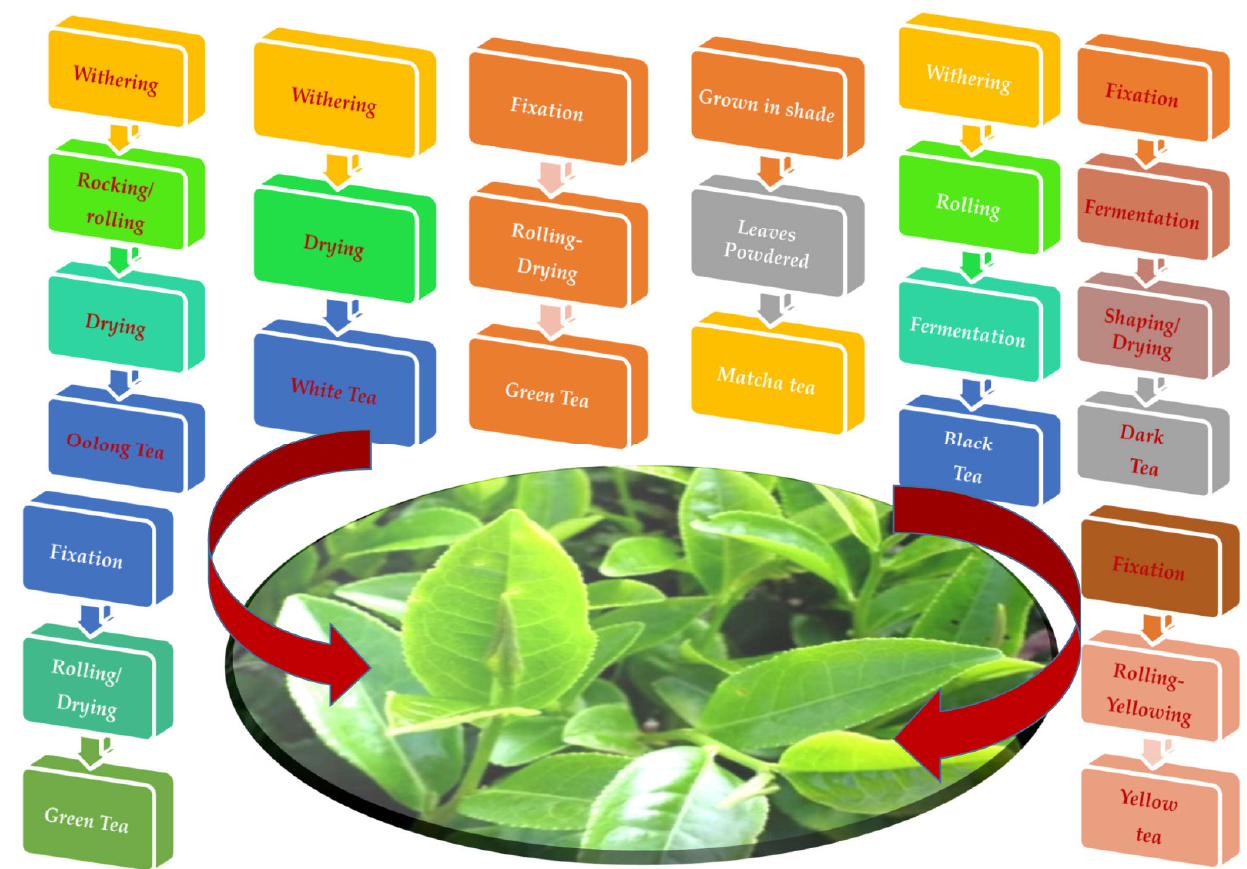
Figure 2. Diverse processing types that determine various teas.